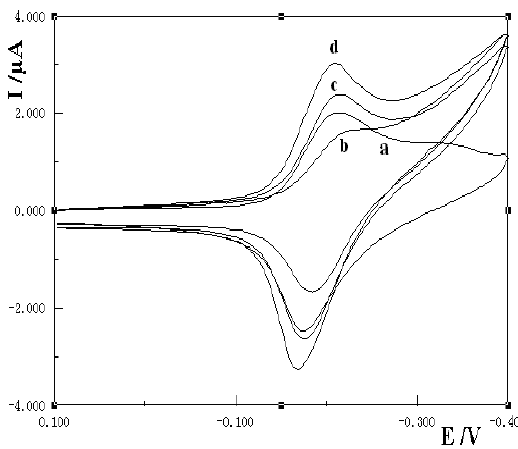
Figure 1. Cyclic voltammograms of 1.5×10 -4 mol/L MB on different kinds of electrodes; a) bare Au; b) MAA/Au; c) ssDNA/MAA/Au; d) dsDNA/MAA/Au in 0.2 mol/L pH 6.0 B-R buffer, scan rate: 100